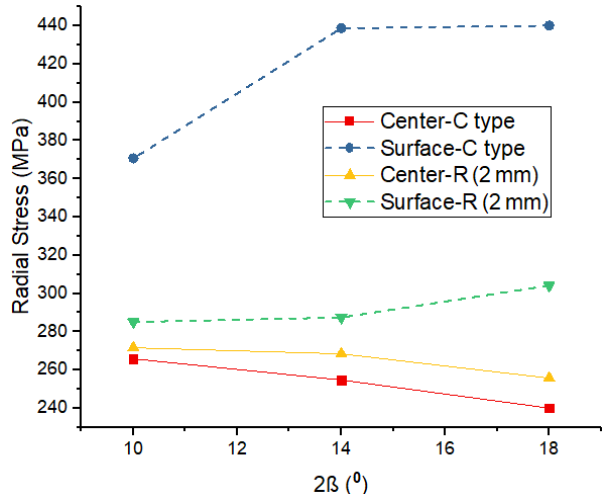
Figure 6. R adial stress in the center and surface of the material for several 2β . Figure 6. Radial stress in the center and surface of the material for several 2 β